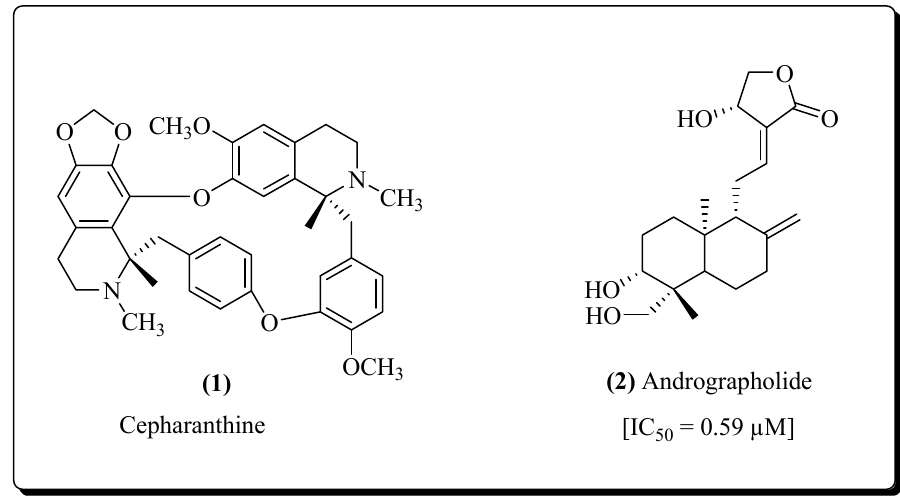
Figure 3. Structures of fusion inhibitors.